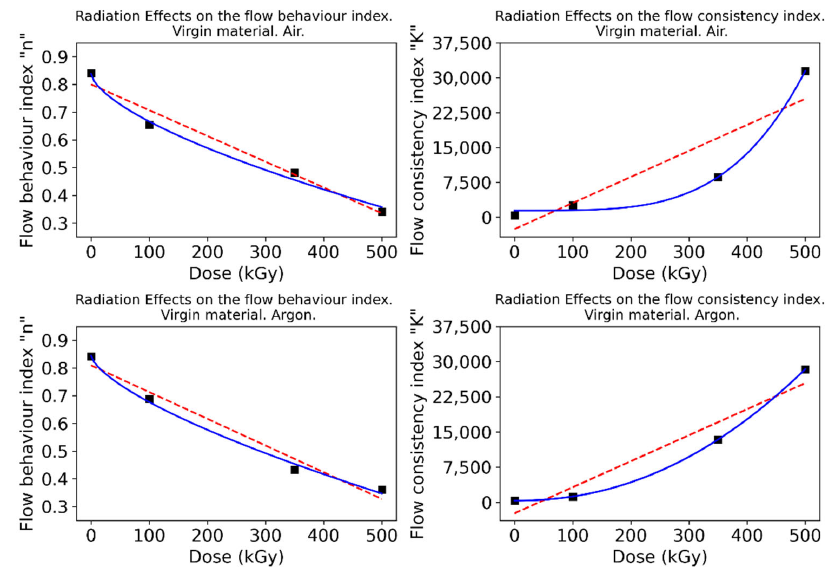
Figure 5. Dependence of the flow behavior and flow consistency indexes to the absorbed dose. Virgin material.